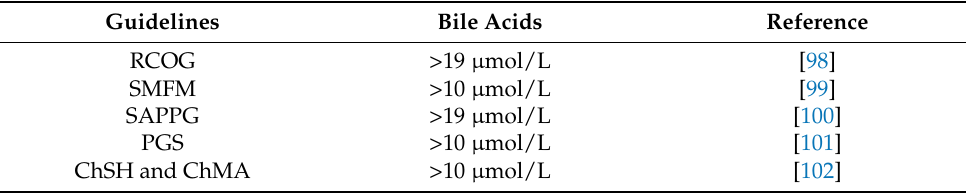
Table 1. The reference range of serum BAs’ concentration in the diagnosis of